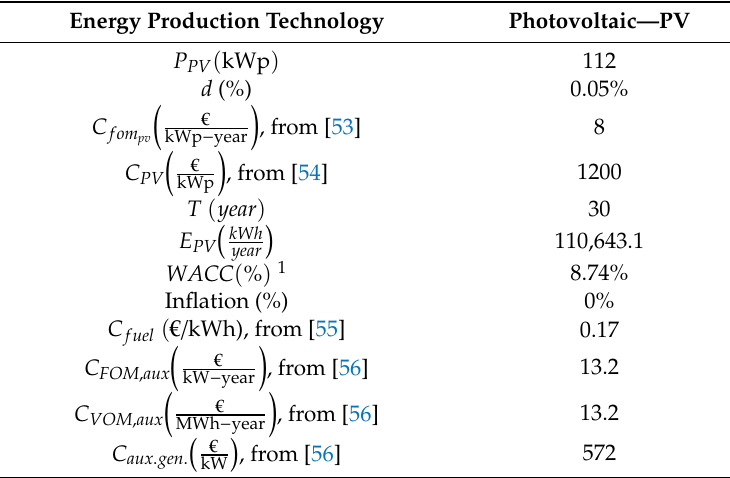
Table 1. Specifications and costs for the photovoltaic system.